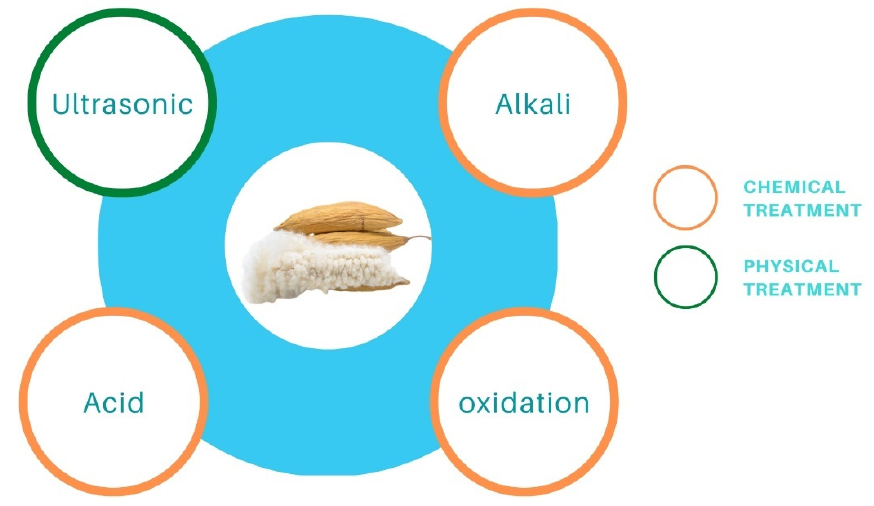
Figure 3. Several treatment methods for kapok fiber to remove the